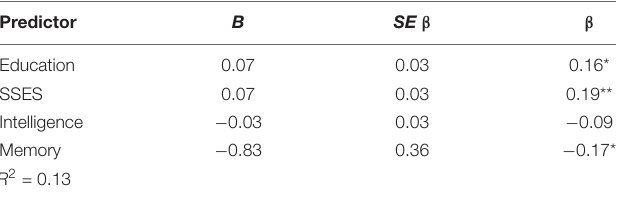
TABLE 3 | Multiple regression predicting GHPS (health behaviours) ( N =